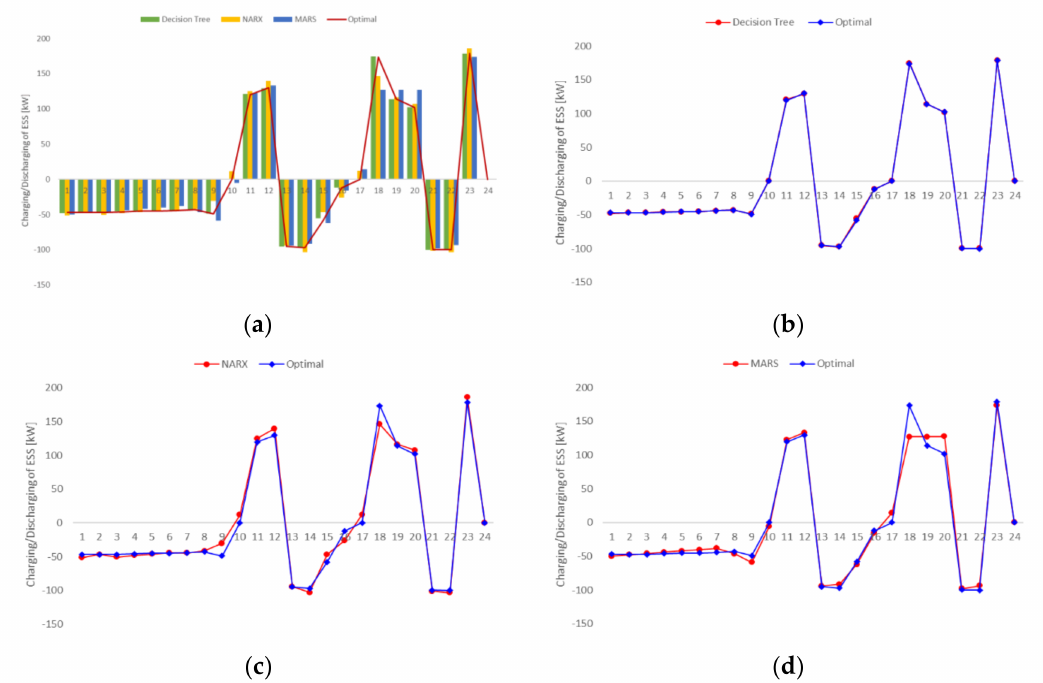
Figure 10. ( a ) Optimal schedule of ESS for minimization of operation cost at winter, ( b ) real and simulation results with DT, ( c ) real and simulation results with NARX, ( d ) real and simulation results with